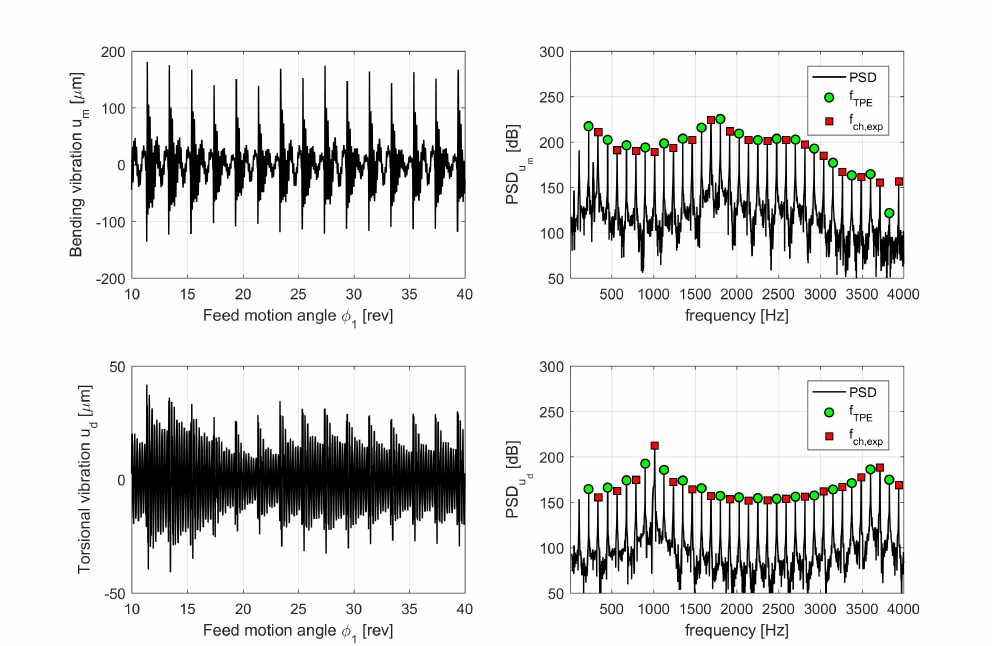
Figure 15. Behavior in time and frequency domain of blade tip vibrations under flip chatter type, dominated by the first torsional vibration mode. Blade type: lattice filled with powder. Cutting parameters: n = 13,500 rpm, a p = 4 mm. Blade vibrations are derived from dynamometer signals. TPE = tooth pass excitation